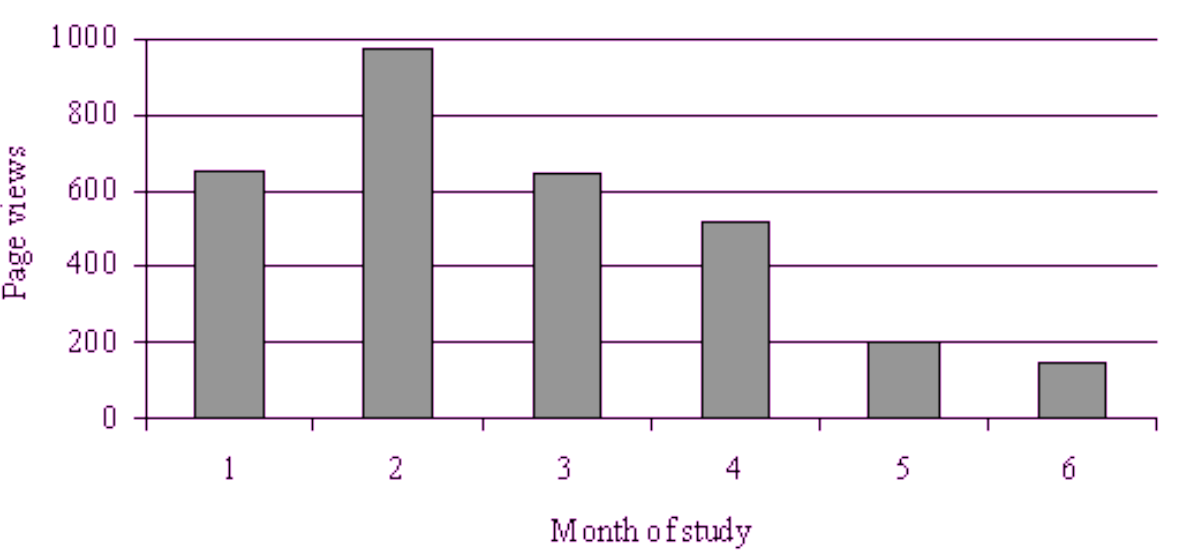
Figure 3. Number of page views per